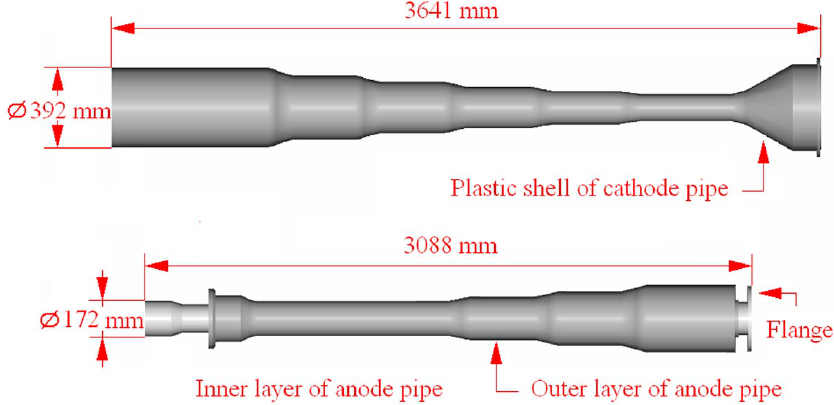
FIG. 10. (Color) Matched cathode (above) and anode (below) stalk.